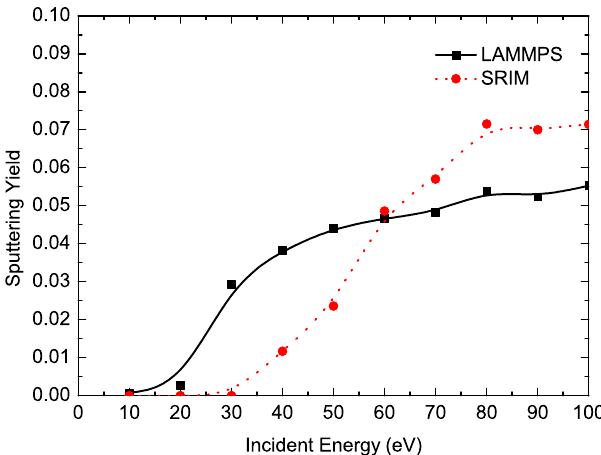
Figure 3. The sputtering yield of SiC bulk with 62 at % C concentration as a function of the incident